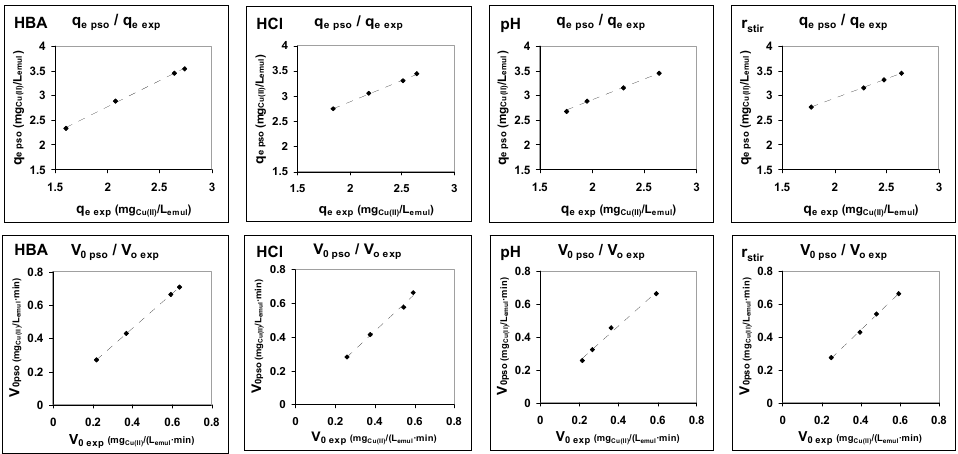
Figure 4. Relationship between experimental and pseudo-second-order model values of parameters q e and V 0 .